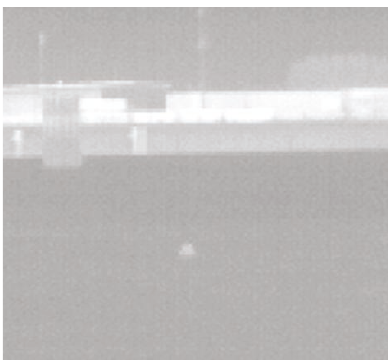
Figure 4: Floating target on a perfectly flat water